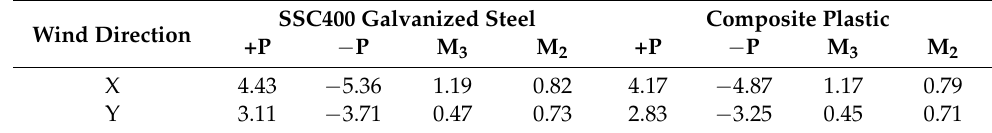
Figure 3. Locations of peak displacement response under the design wind load. Table 5. Comparison of peak internals under equivalent wind load (kN, m). Table 5. Comparison of peak internals under equivalent wind load (kN, m).